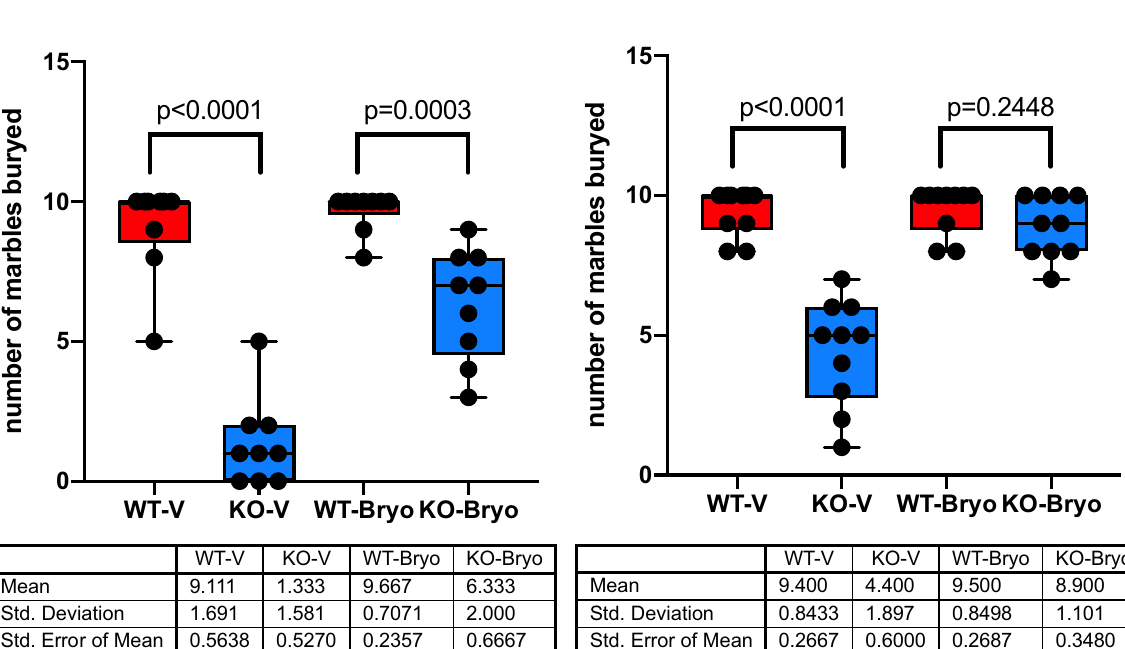
Figure 3. Chronic bryostatin-1 rescues impaired marble burying activity of the Fmr1 KO2 mice. Wild-type (WT) or Fmr1 KO2 (KO) adult mice were treated with vehicle (V) or bryostatin-1 (Bryo) for 5 weeks (Study 1) or 13 weeks (Study 2) and then tested in marble burying activity. Thirteen week treatment with Bryostatin 1 significantly improves hippocampal dependent marble burying behavior in Fmr1 KO2 mice when compared to wild type littermates ( P = 0.2448). Data is visualized as boxplots with interquartile ranges, presenting all the data points. The table indicates the mean standard deviation and the standard error of the mean (N = 10 mice per